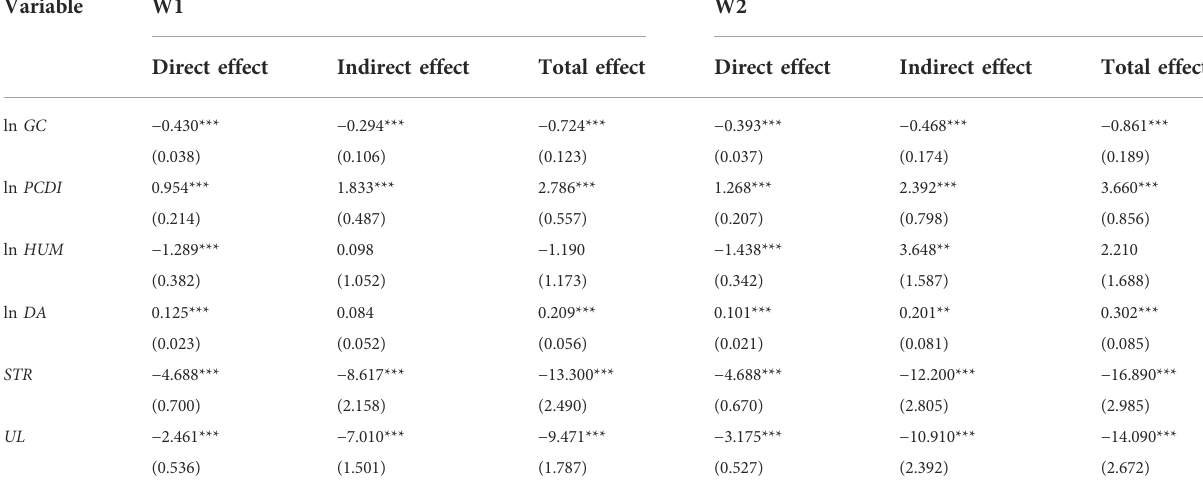
TABLE 8 Spatial effect decomposition results.